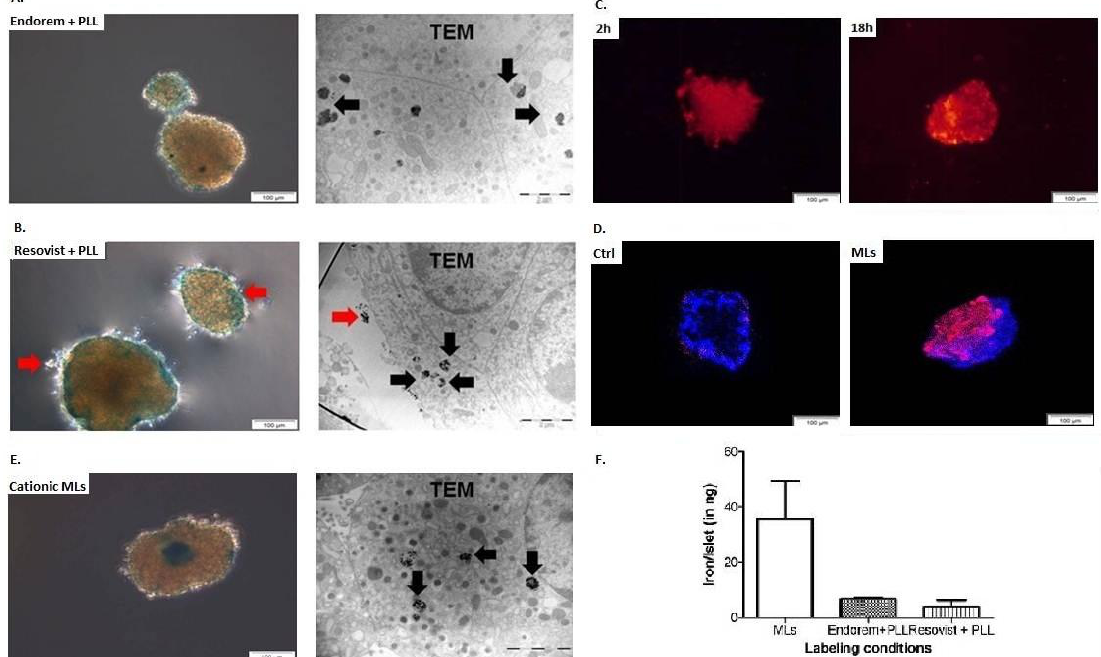
Figure 3. Iron uptake by rat islets: Iron uptake by pancreatic islets (PIs) was confirmed by Prussian blue staining and transmission electron microscopy (TEM), when labeled with ( A ) Endorem + PLL, ( B ) Resovist + PLL, and ( C ) cationic MLs. PIs labeled with Endorem + PLL and Resovist + PLL showed heterogeneous uptake in different islets of the same batch. MLs showed uptake already after 2 h, and elevated uptake was observed after 18 h of co-incubation with MLs. ( D ) Confocal microscopy was performed to confirm the uptake of the MLs by PIs. ( E ) Prussian blue staining and TEM were performed to confirm the uptake. The presence of particles adhered to the cell membrane is indicated by red arrows for the Prussian blue and TEM images. ( F ) Iron content in the labeled PIs ( n = 2) was measured with inductively-coupled plasma optical emission spectrometry (ICP-OES). Scale bar: 2 μm for TEM; data expressed as mean ± SD.